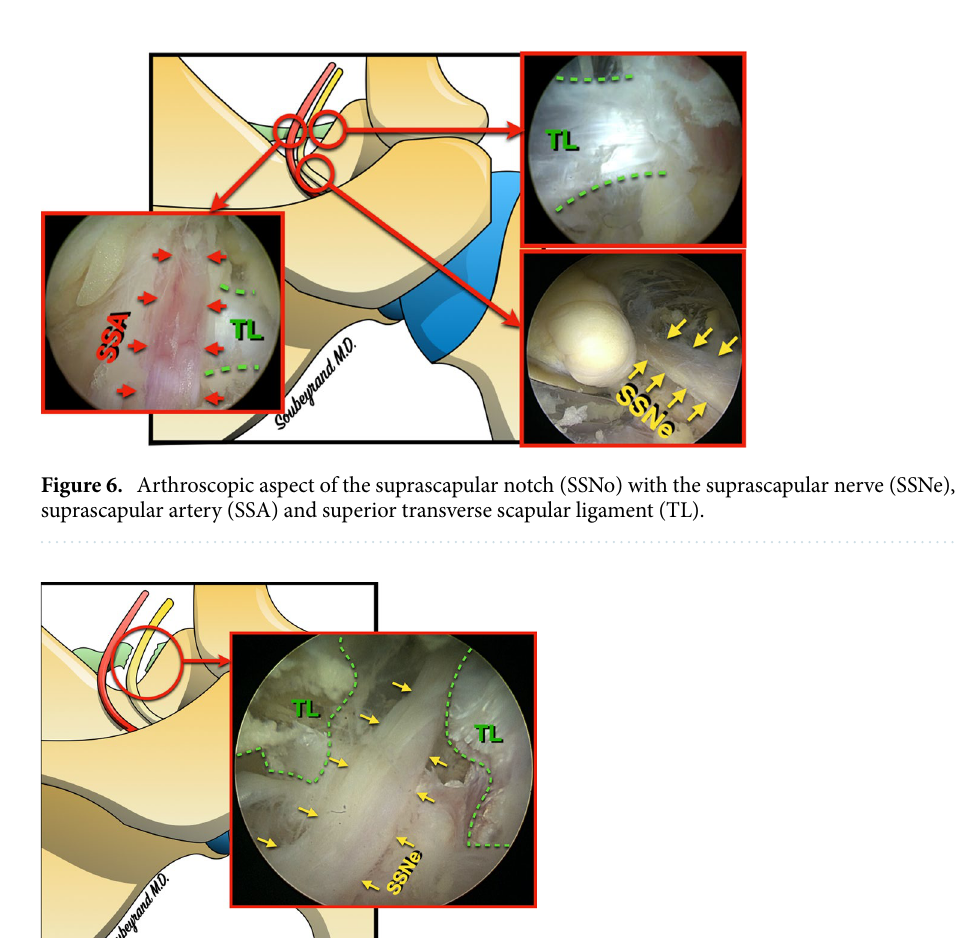
Figure 5. Two arthroscopic portals are created on either side of the probe (medial and lateral) in order to introduce the arthroscope and a blunt trocar. The trocar is used to create a working space around the notch: its tip is used to detach the soft tissue. The workspace gradually appears as a hypoechoic area. The arthroscope is then introduced under ultrasound guidance into the working area.